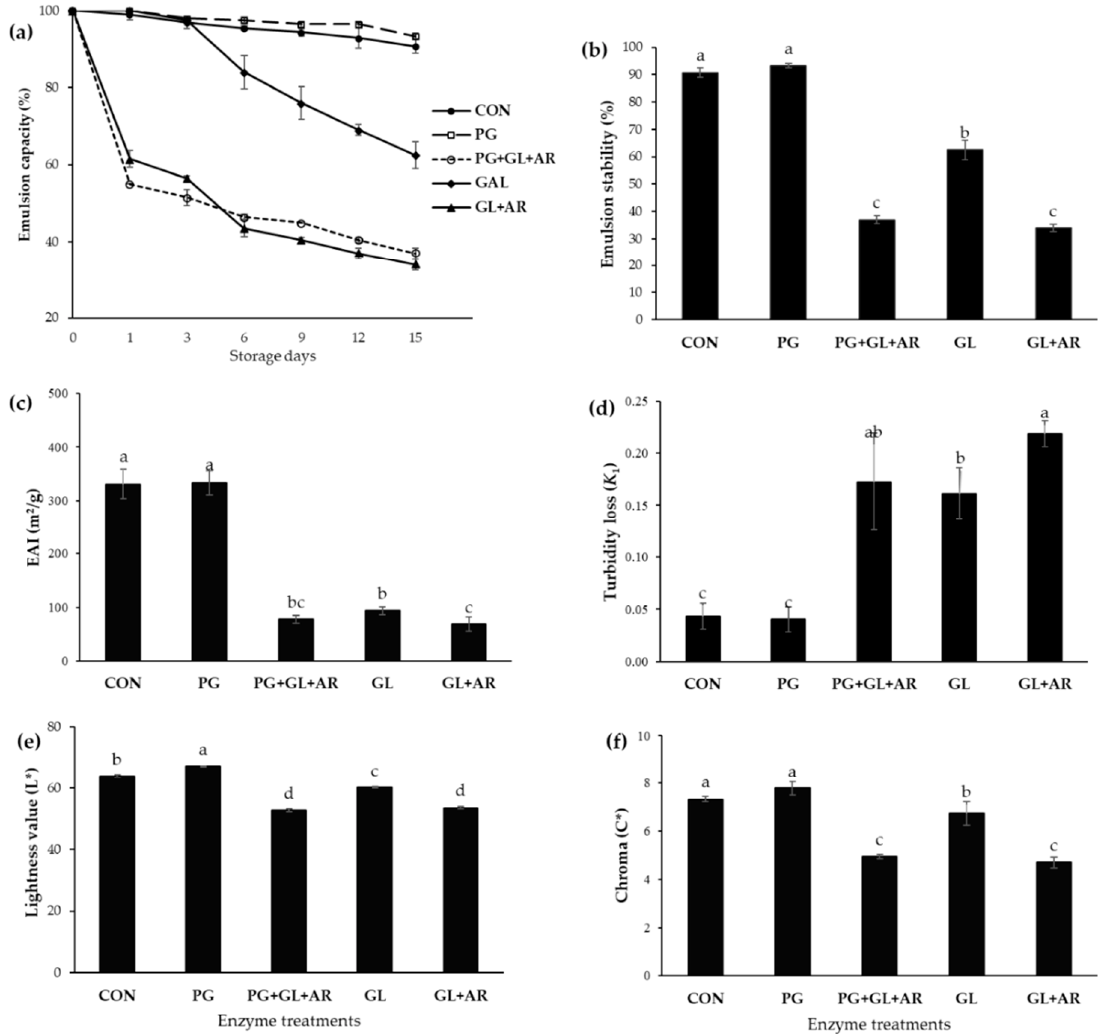
Figure 3. Emulsion characteristics of OKP following enzymatic treatments. Emulsion capacity during 15-day storage at 25 °C ( a ), emulsion stability ( b ), emulsion activity index EAI ( c ), and emulsion turbidity loss ( d ), after 15 days of storage at 25 °C. The lightness ( e ), and Chroma color values ( f ) of emulsions were measured immediately after preparation. Values represent mean ± standard deviation ( n = 3), and letters (a–d) represent significant differences between samples ( p < 0.05). Color parameters including lightness (L* value) and chroma (C* value) have been previously used to assess emulsion characteristics [36]. The droplet characteristics (size and aggregation) are related to the lightness and chromaticity of emulsions. An increase in